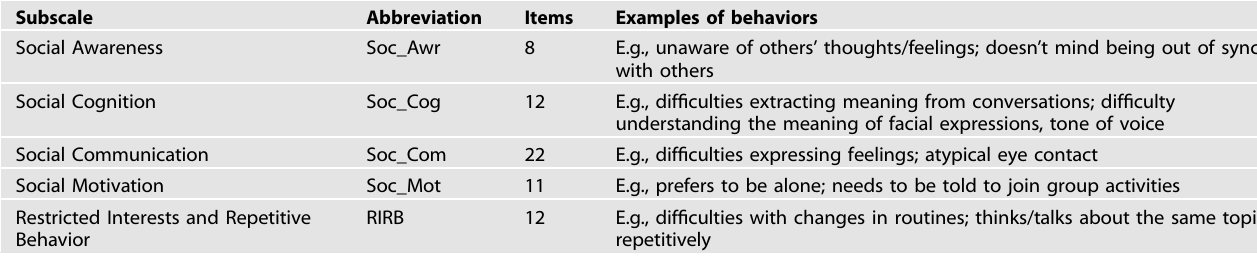
Table 2. SRS-2 treatment